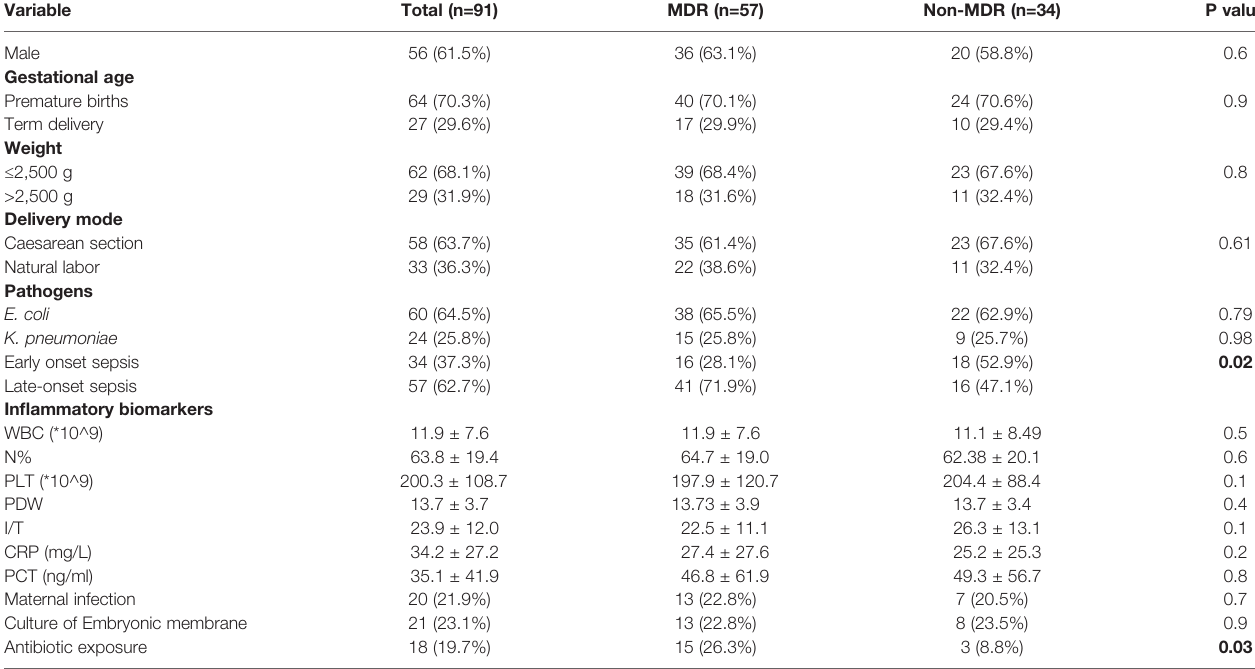
TABLE 7 | Clinical data analysis of neonatal infection with MDR from 2017 to 2019.